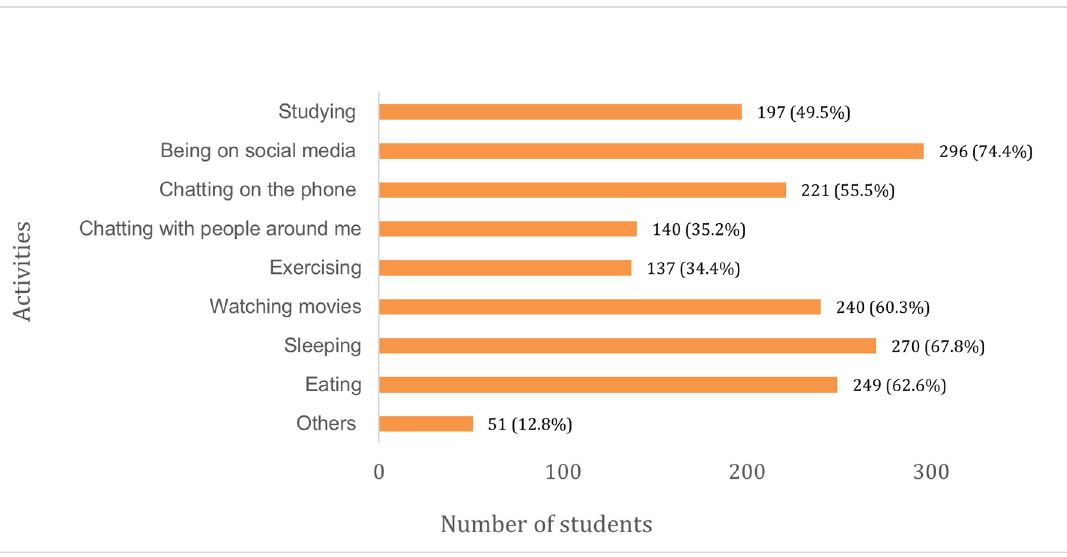
Fig 10. How students spent most of their time during the